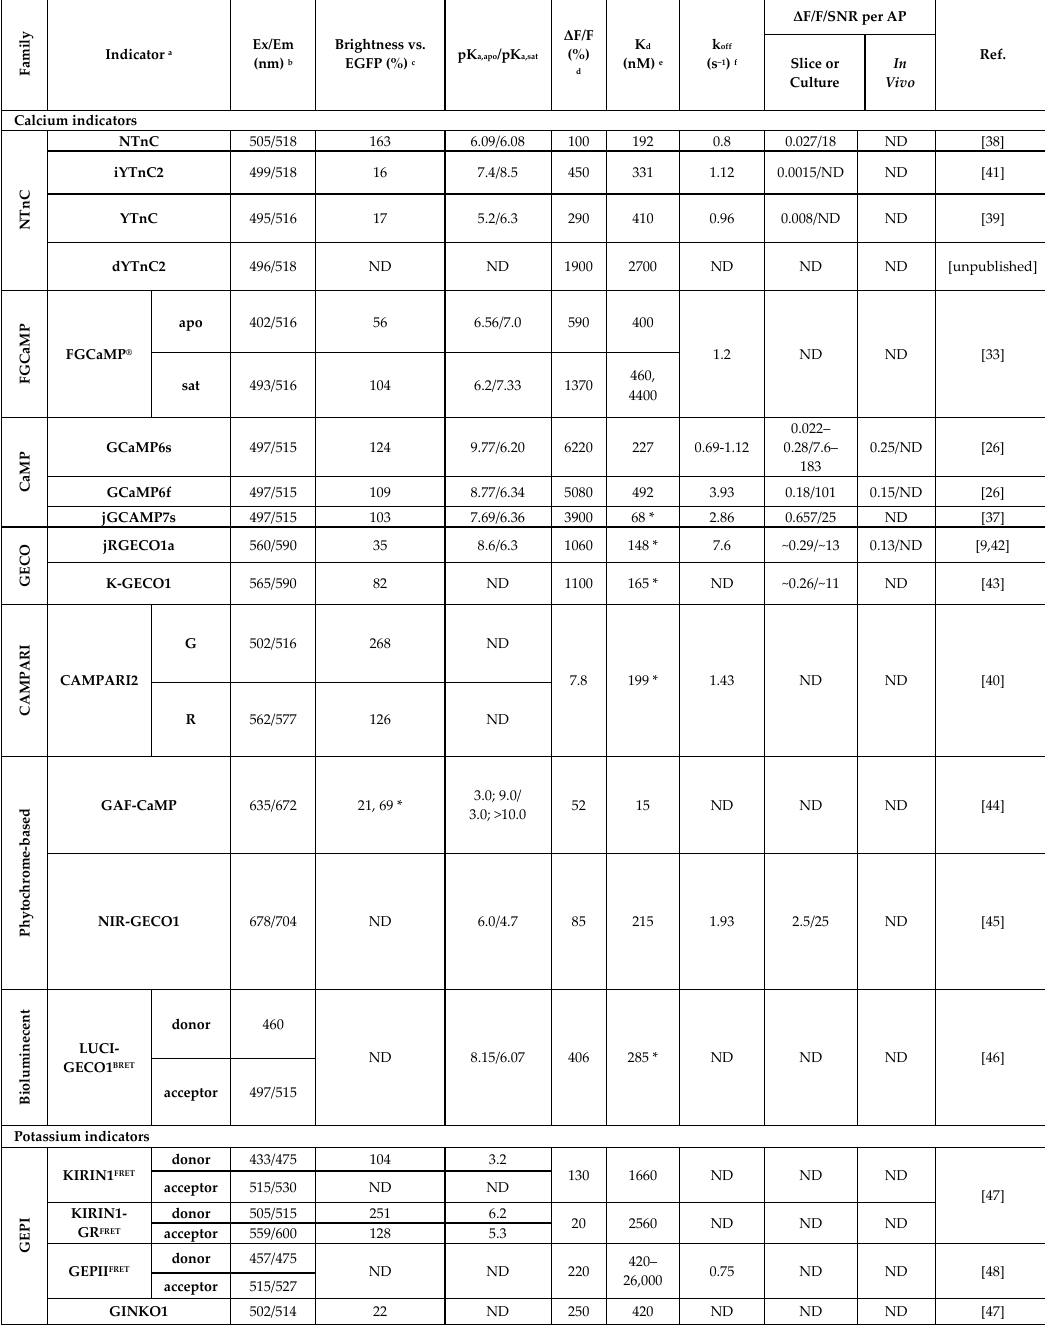
Table 1. The key characteristics and performance of the selected genetically-encoded fluorescent calcium and potassium indicators.